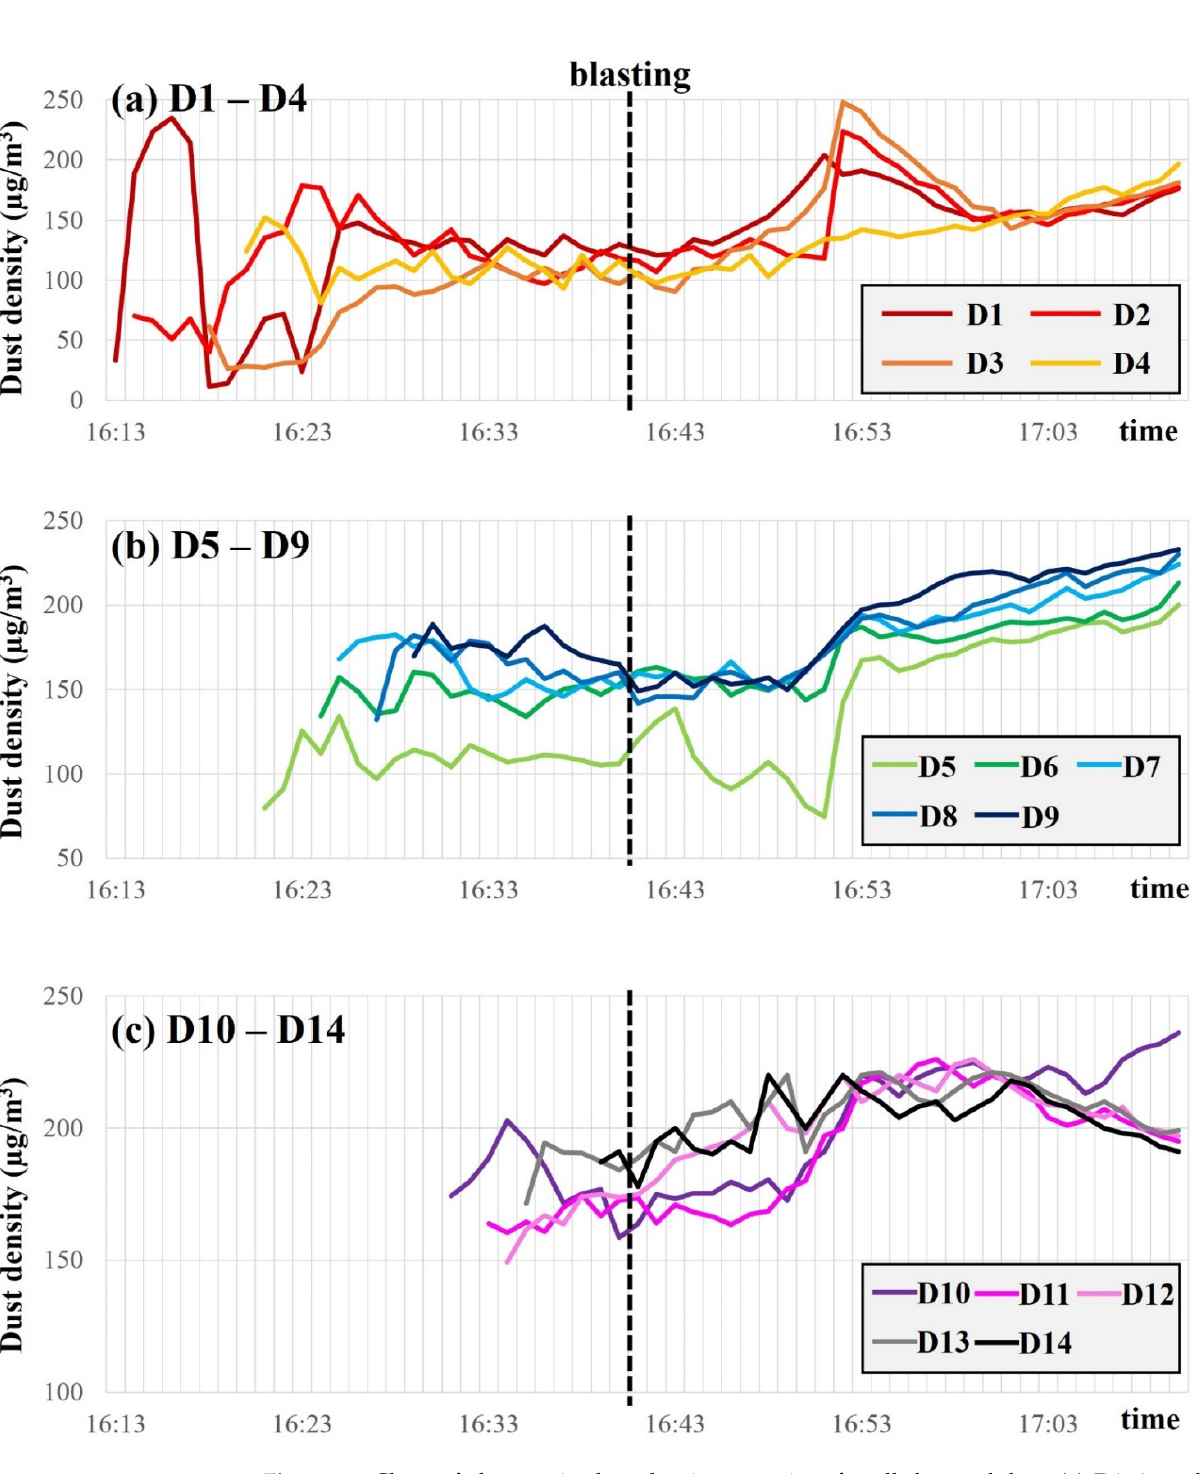
Figure 9. Chart of changes in dust density over time for all the modules. ( a ) D1–4 modules, (b) D5– 9 modules, and ( c ) D10–14 modules.